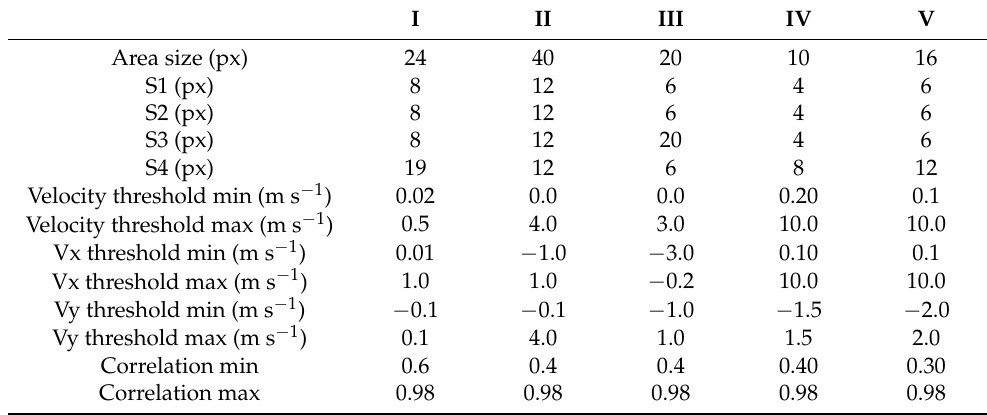
Table A1. Fudaa-LSPIV parameters of case studies, (I) Kolubara River, (II) Murg River, (III) Salmon River, (IV) Loussios river at of Atsicholos Bridge, (V) Loussios river upstream of Atsicholos Bridge.